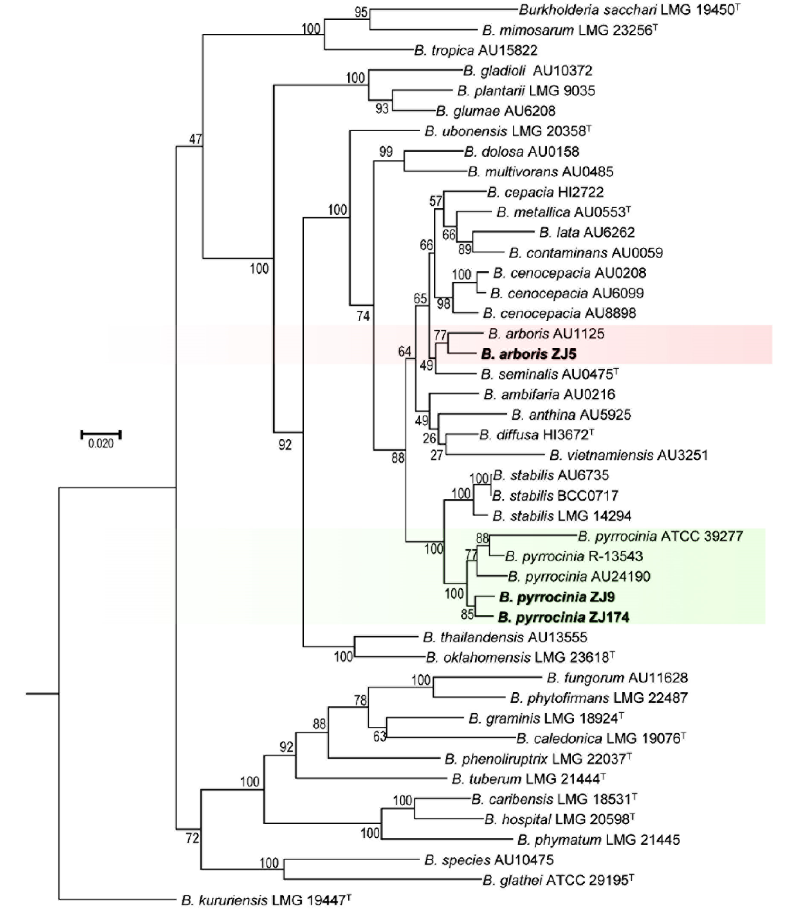
Figure 9. Maximum likelihood (ML) tree was generated with RaxmlGUI v. 1.5 from the combined atpD , gltD , gyrB , recA , lepA , phaC and trpB genes sequences of 45 taxa of Burkholderia . The reference sequences of each species were downloaded from the Burkholderia cepacia complex multilocus sequence typing website (http://pubmlst.org/bcc/; August 26, 2021). The tree is rooted with B. kururiensis LMG 19447 T . Bootstrap scores (1000 replicates) are displayed at each node. Bacterial strains isolated from soil in this study are shown in bold. Type strain was indicated with T.